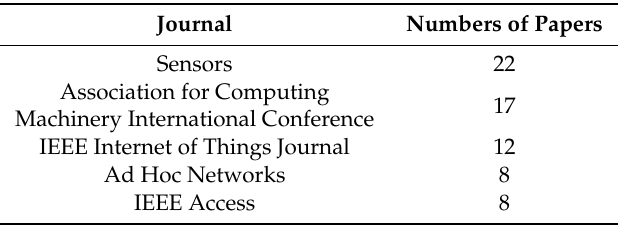
Table 3. Number of papers in scientific journals from 2015 to 2019. ACM: